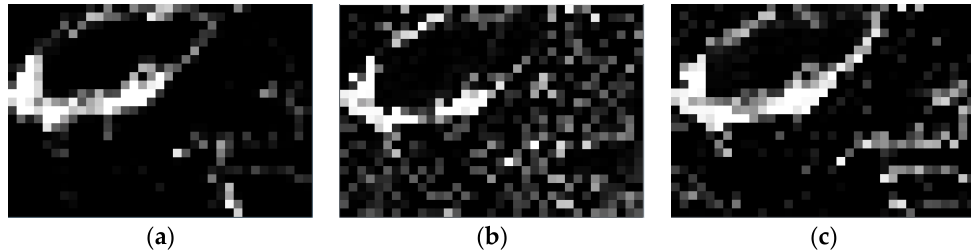
Figure 6. The different fractional difference images corresponding to water. ( a ) fractional difference image reference; ( b ) fractional difference image produced by the linear mixture model (LMM), and ( c ) fractional difference image produced by the LMM model with selective endmember model (LMM_SE).